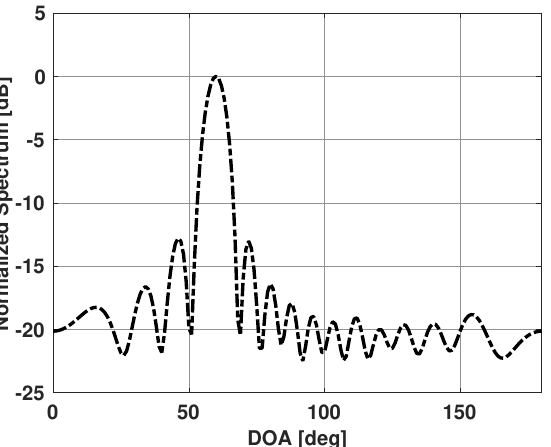
Figure 1. Bartlett spectrum versus direction of arrival (DOA) for a uniform linear array of 15 elements in the presence of a single signal incident at 60 ◦ .